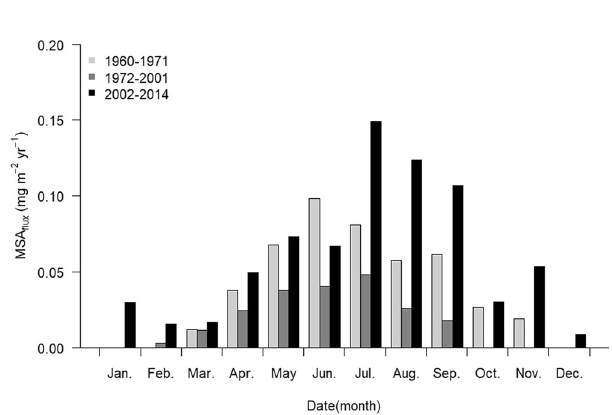
Fig. 3 Monthly MSA fl ux . The bar graphs colored by light gray, dark gray, and black denote the monthly MSA fl ux from 1960 – 1971, 1972 – 2001, and 2002 – 2014, respectively. The MSA fl ux is the mean value for each period